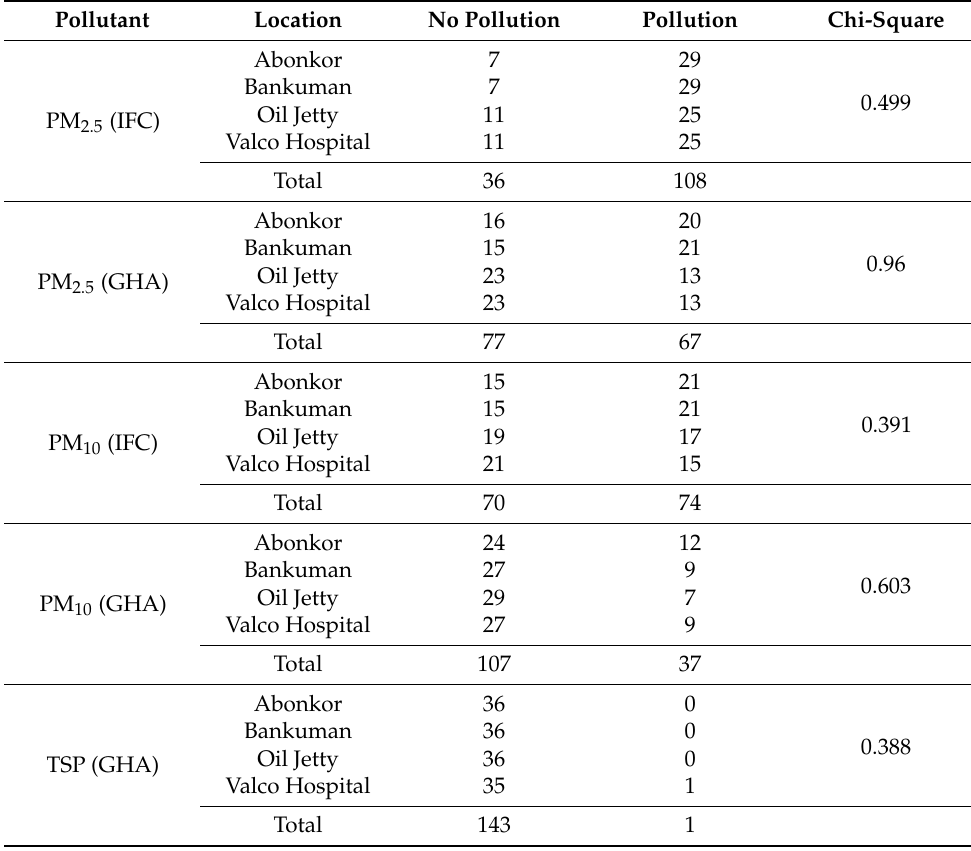
Table 3. Dust pollution across the selected locations base on the IFC and Ghana